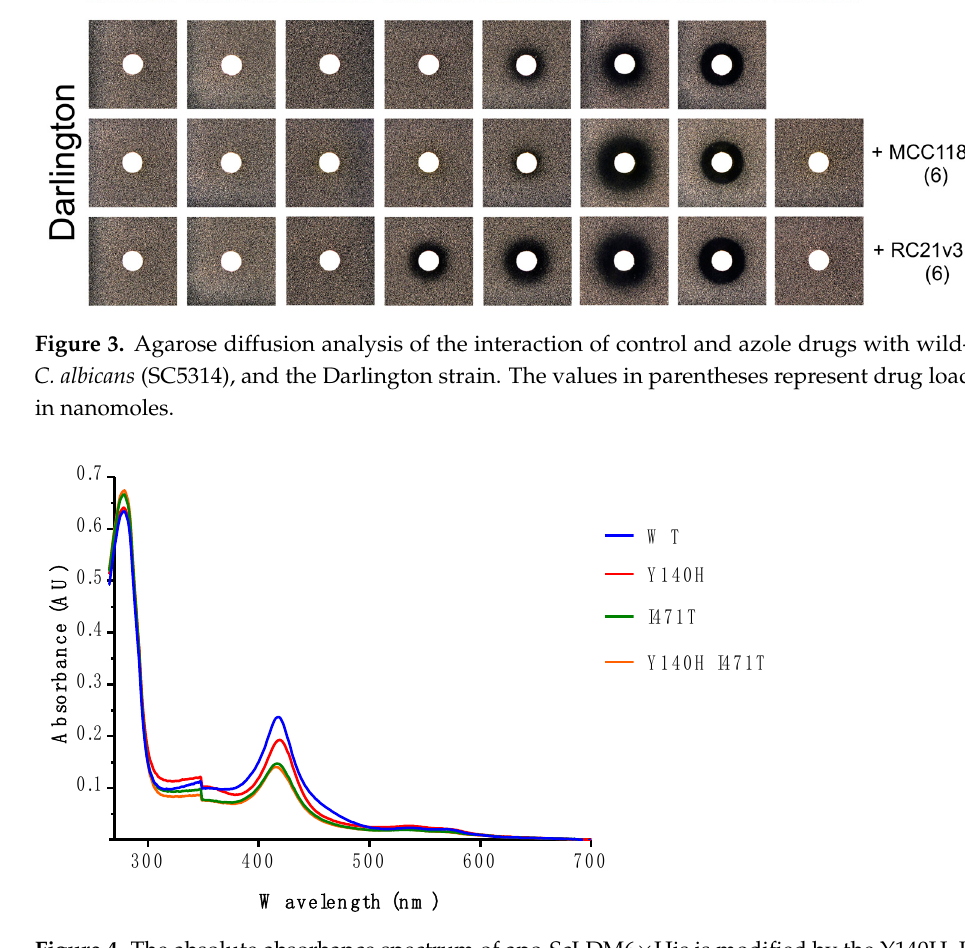
Figure 5. The I471T mutation affects binding of VCZ and ITC to affinity-purified ScLDM6×His. Difference spectra obtained in the presence of saturating ( a ) VCZ (3 µM) and ( b ) ITC (3 µM) with 2 µM ScLDM6×His wild-type and ScLDM6×His I471T are shown on the top of each figure, and the curves for type II binding saturation are shown on the bottom with ScLDM6×His wild-type (cir- cles) and ScLDM6×His I471T (triangles).